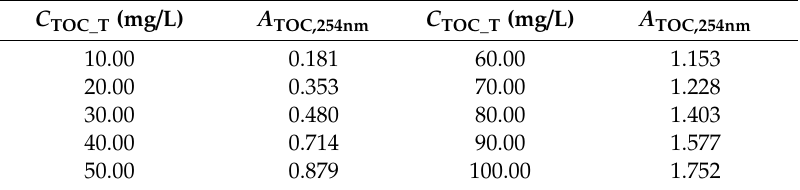
Table 5. Absorbance of di ff erent concentrations of TOC standard solution at 254 nm. C TOC_T (mg /